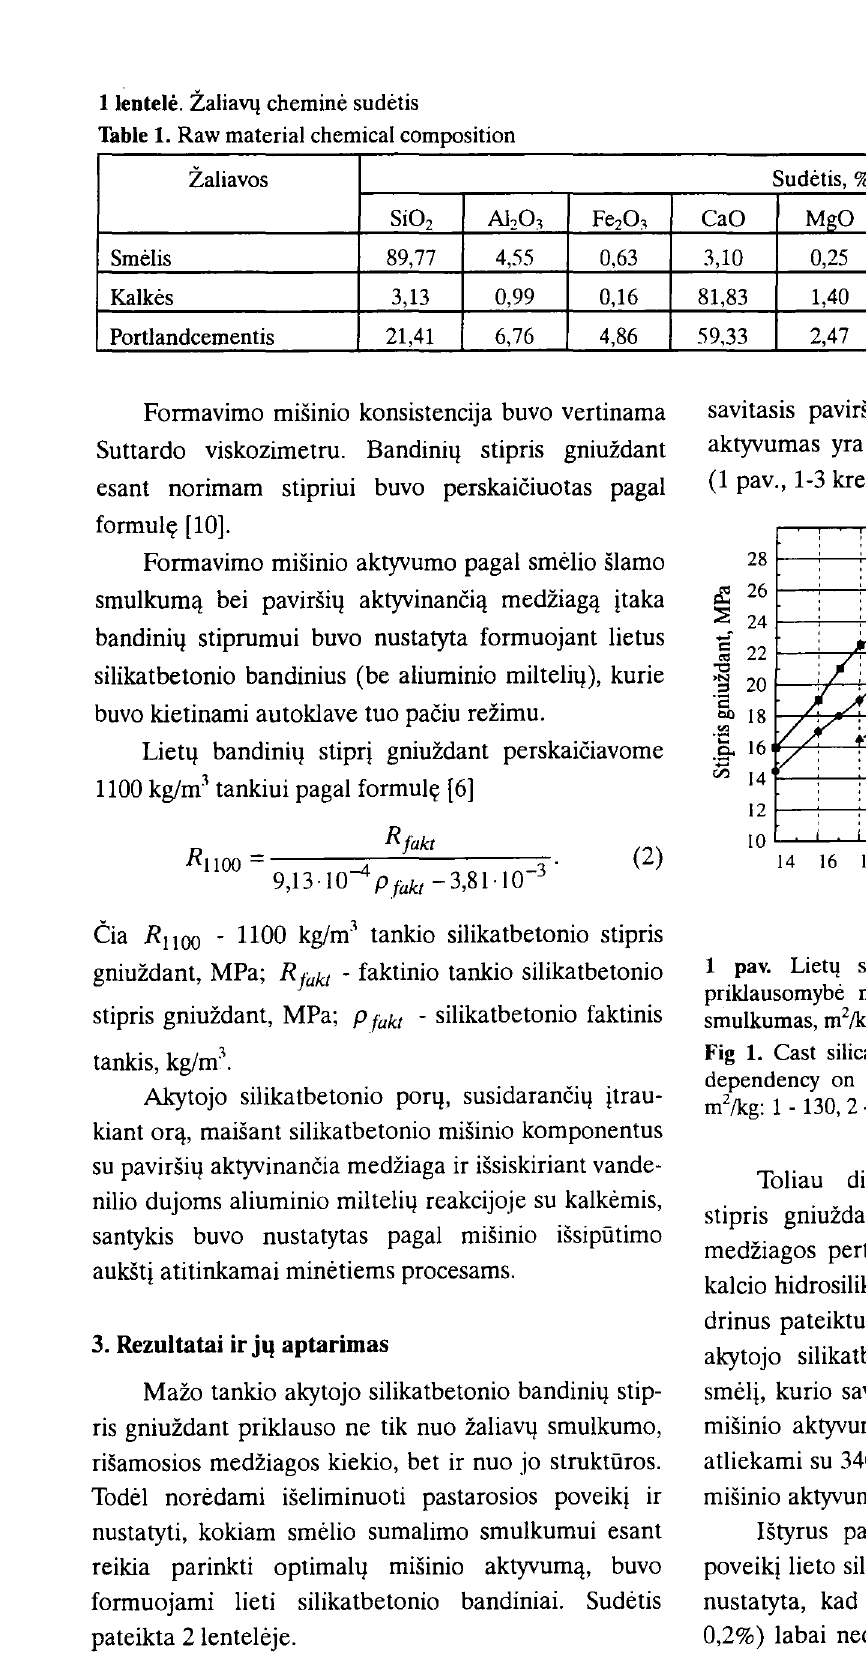
Table 1. Raw material chemical composition Zaliavos